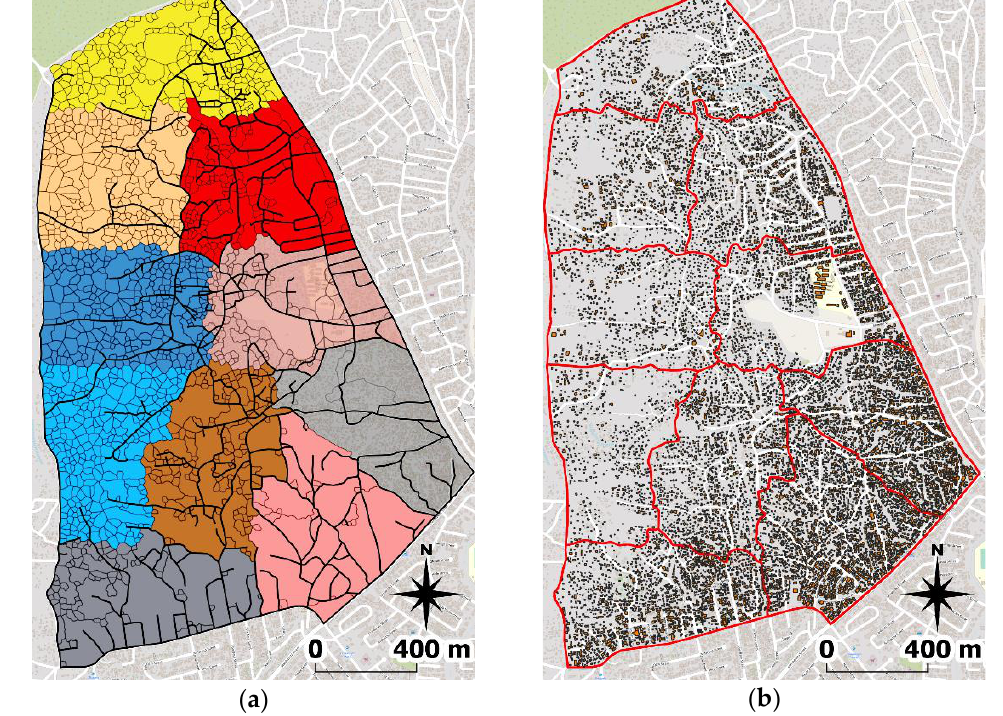
Figure 8. Final area division: colored districts ( a ); main pipeline routes for basic service provision ( b ) (basemap/buildings/polygons: [47]).